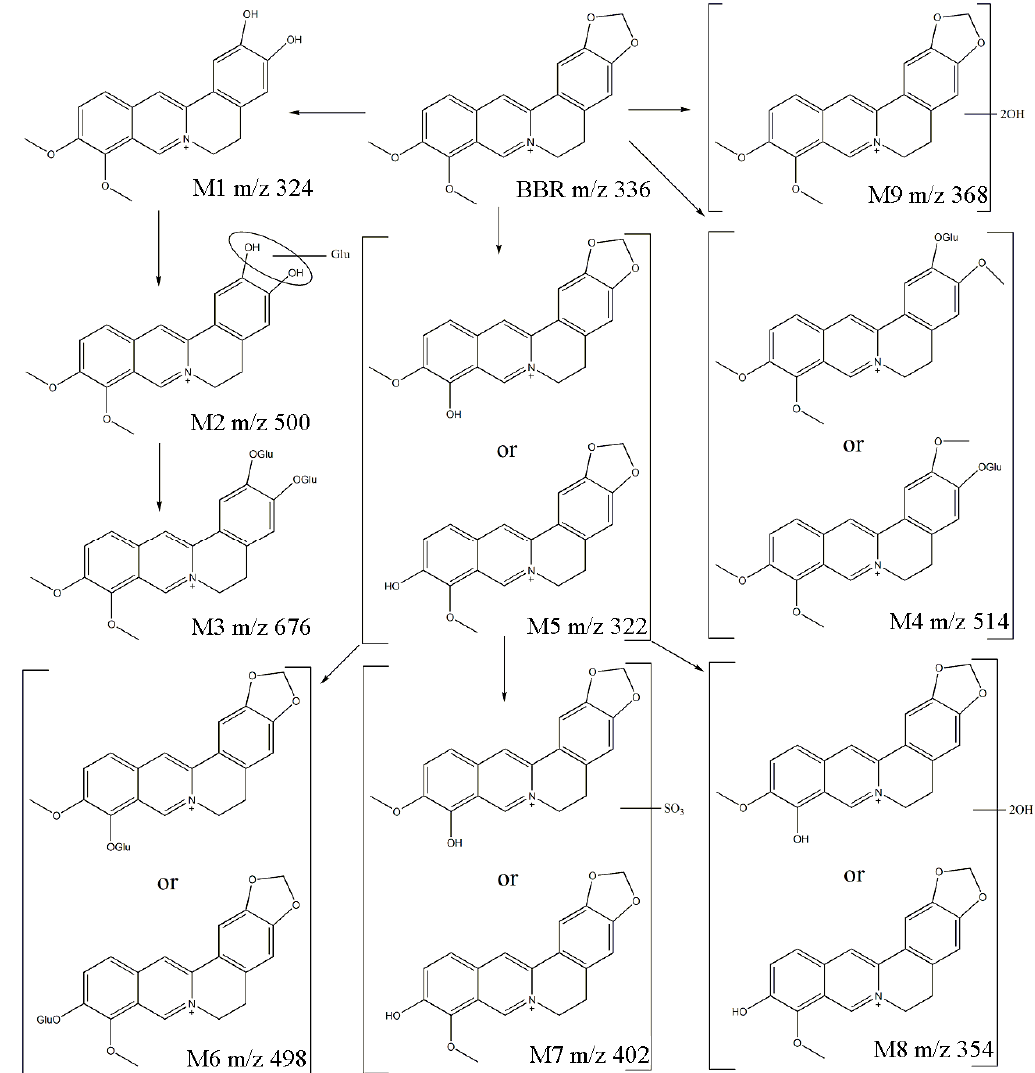
Figure 5. Structures of berberine metabolites and the possible metabolic pathways of berberine in rats.